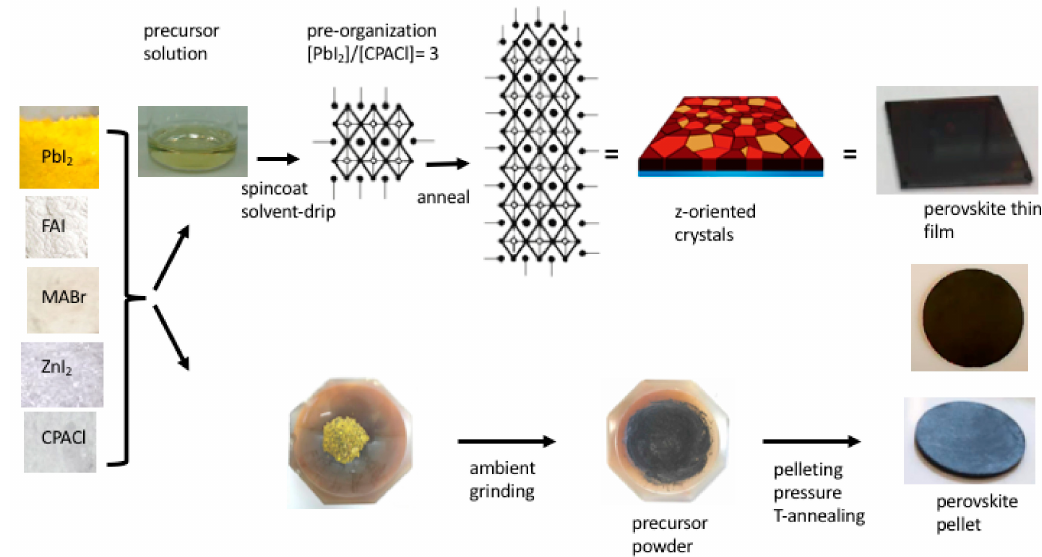
Figure 3. Formation of films and pellets from their starting components. Decreasing ratio CPACl: FA / MA, annealing or grinding steps are indicated. The crystalline units form a larger well-organized and protected final product. See Reference [16] for more information on this composition.